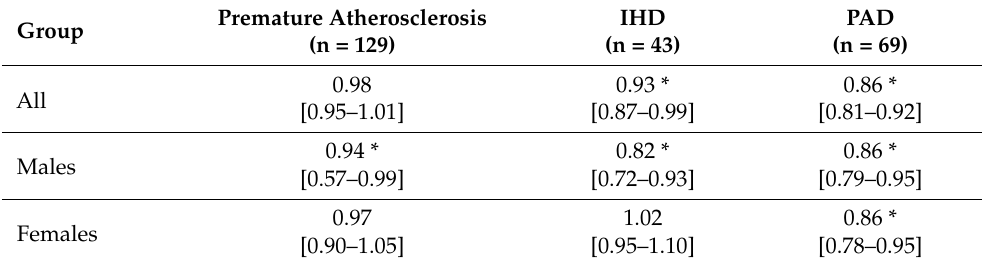
Table 3. Risk of atherosclerotic disease with each µ mol/L increase of serum bilirubin concentration.